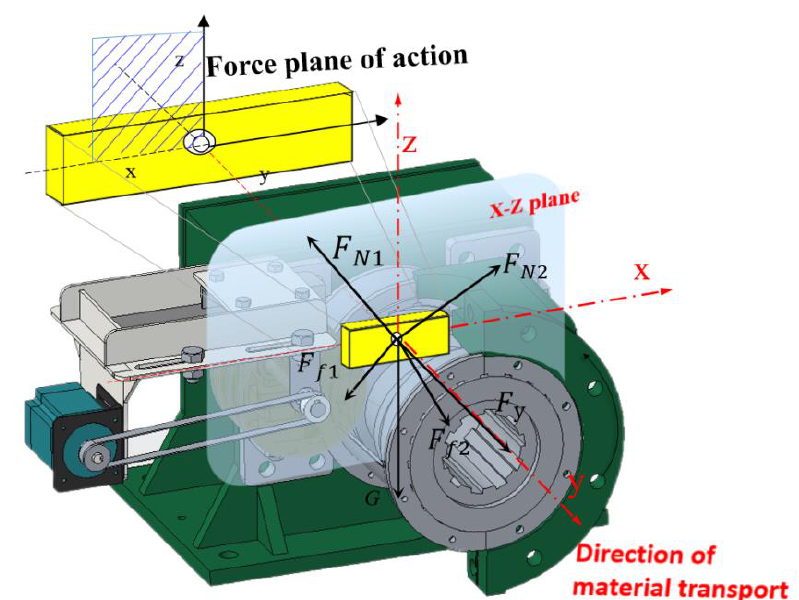
Figure 4. Analysis of straw feeding mechanics.